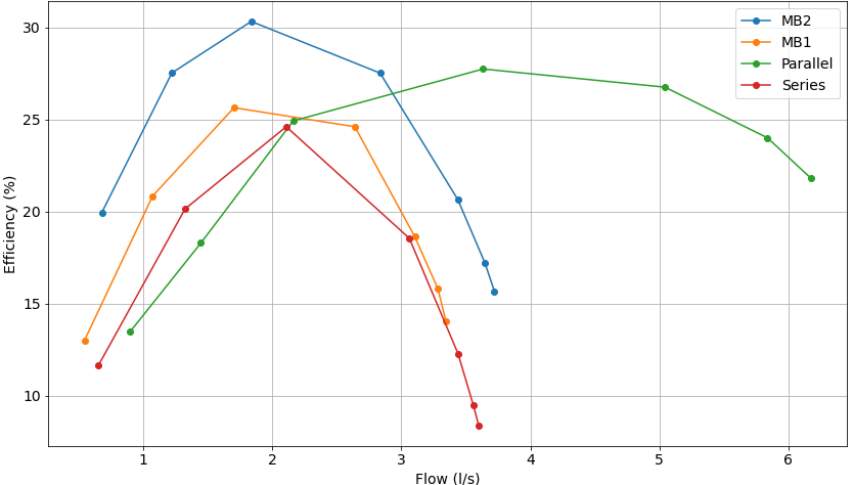
Figure 14. Comparative characteristic curve of the energy efficiencies of pumps operating at 50